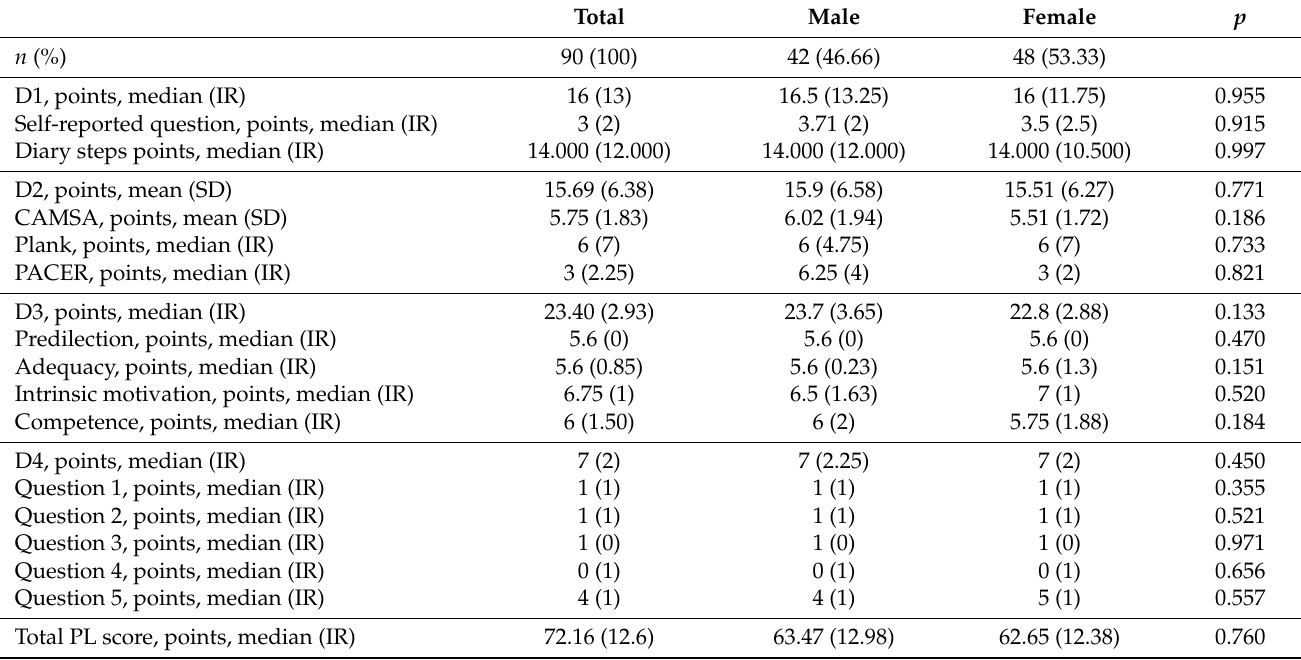
Table 3. Physical literacy outcomes for total sample and between-sex comparisons, including their different domains.